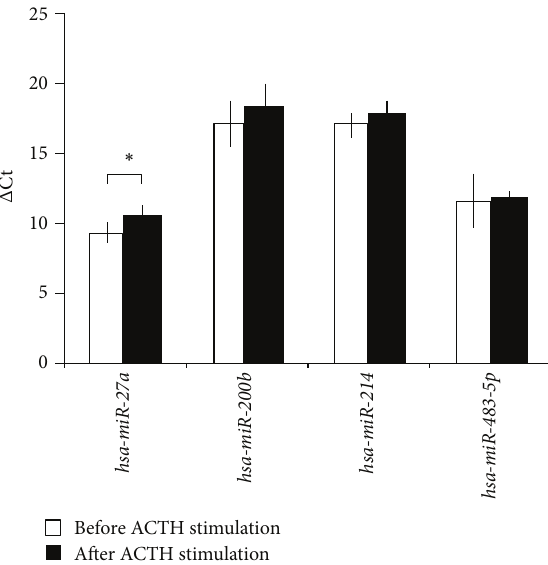
Figure 2: Expression change of microRNAs in plasma after 250 𝜇 g tetracosactide test, normalized to cel-mir-39 . Δ Ct values are repre- sented: increased Δ Ctindicates lower expression, whereas decreased Δ Ct indicates higher expression (mean ± SD). ∗ 𝑝 < 0.05 , 𝑛 = 10 . Results of Mann-Whitney 𝑈 test.